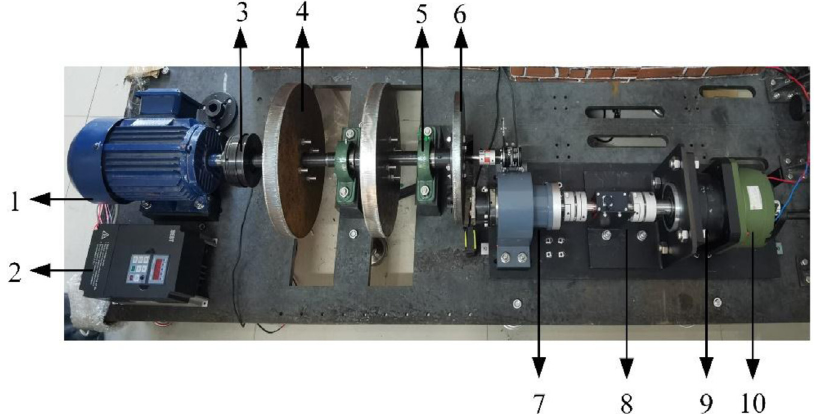
Fig. 14. Real picture of dynamic brake. 1. Three-phase asynchronous motor. 2. Frequency converter. 3. Clutch 4. Flywheel. 5. Bearing